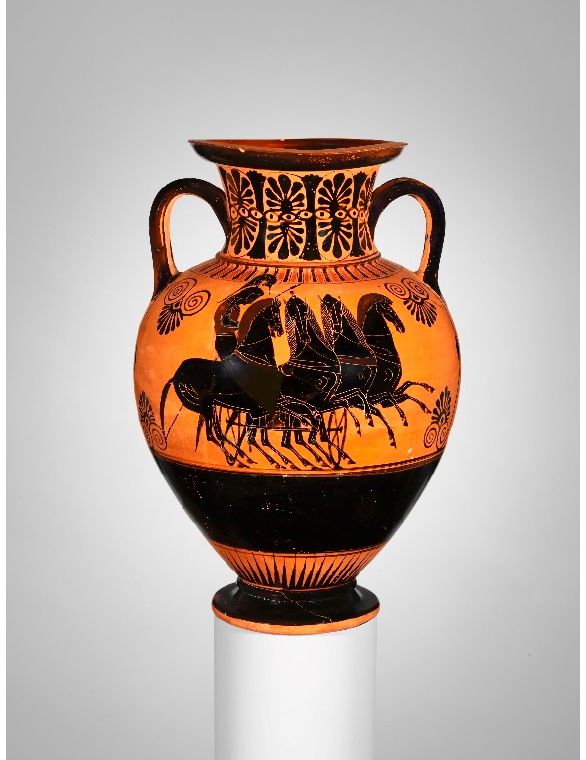
Figure 11. Neck Amphora. Ca. 540-430 BCE. Metropolitan Museum of Art. Pur-chased 1896. Inv no. 96.9.10.